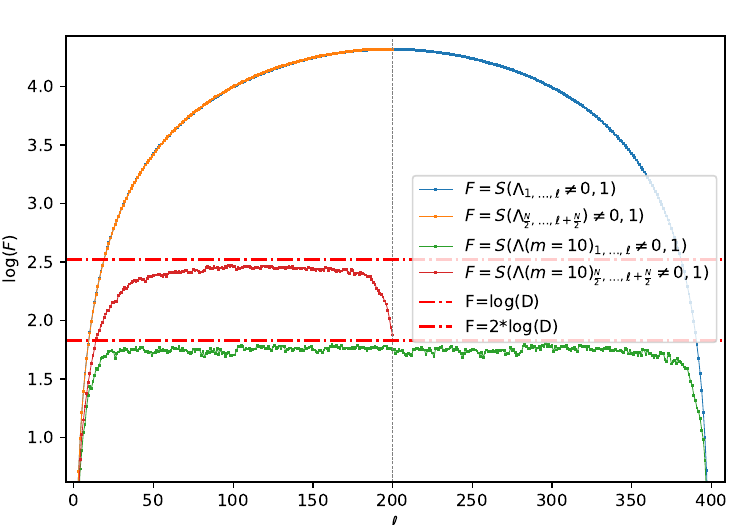
Figure 14: The entropy of different regions of the ground state of a random Hamil- tonian. The blue dots correspond to partitions of dimension (cid:96) with first site at the boundary of the chain. The orange dots correspond to partitions of dimension (cid:96) with first site in the middle of the chain. The green dots are analogous to the blue dots but computed for the state Γ ( m = 1 ) obtained reducing the bond dimension of Γ to m = 1. Red dots are anologous to the orange dots, but computed for Γ ( m = 1 ) . As ex- pected since the Hamiltonian is random and long range the entropy has an extensive scaling with the subsystem size. The red dash-dotted horizontal lines represent the upper bound for the entropy of a partition (starting at the border or not respectively for log ( D ) and 2log ( D ) ). As we can see the entropy is always bounded by S ≤ log ( D ) with D = 2 m as